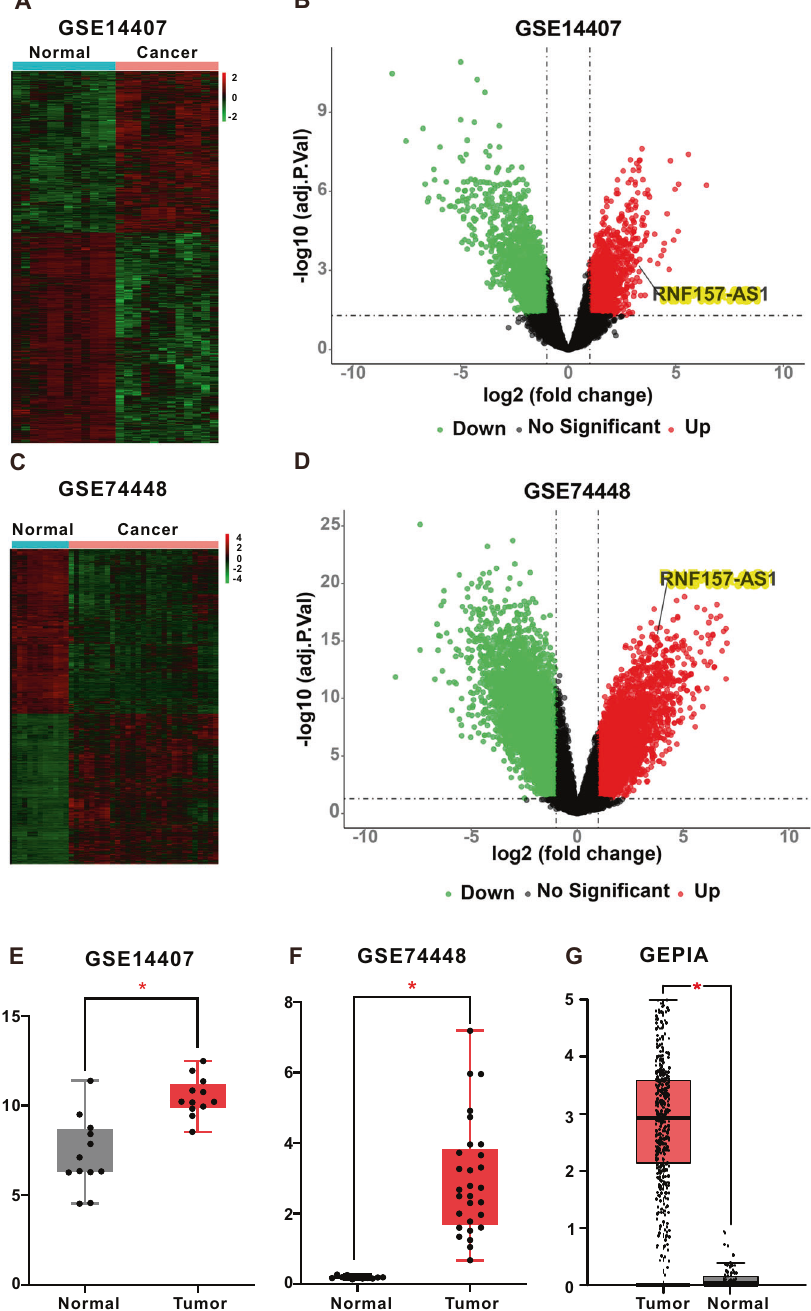
Fig. 1 RNF157-AS1 was overexpressed in EOC tissues. A Differentially expressed lncRNAs in GSE_14407 with hierarchical clustering. B Differentially expressed lncRNAs in GSE_14407 shown on a volcano plot and including RNF157-AS1. C A heatmap was used to show the differentially expressed lncRNAs in GSE_74448. D A volcano plot was used to visualize the differentially expressed lncRNAs in GSE_74448, including RNF157-AS1. E – G RNF157-AS1 was overexpressed in 12 CEPI samples compared with 12 OSE samples in GSE_14407 ( E ), in 29 EOC tissues compared with normal ovarian tissues in GSE_74448 ( F ), and in 426 EOC tissues in the TCGA database compared with 88 normal ovarian tissues in GTEx database ( G